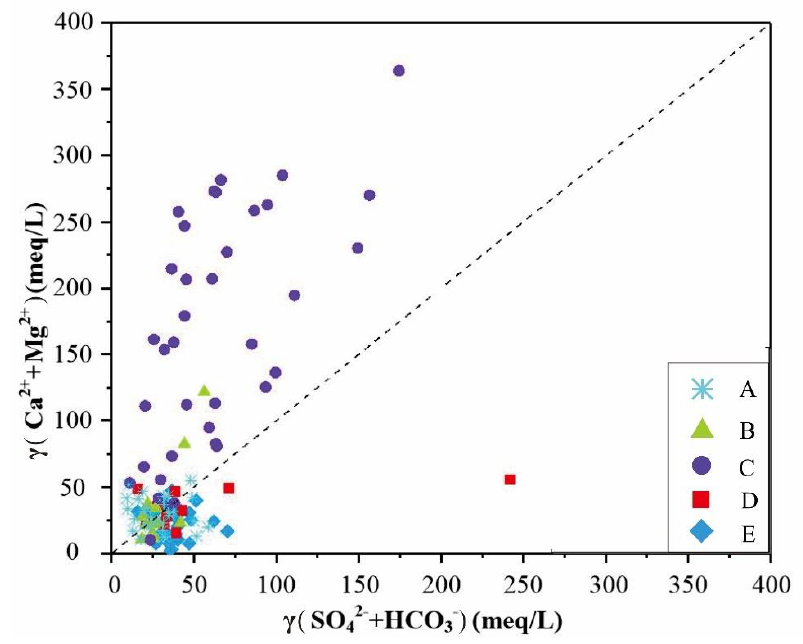
Figure 9. Relationship between γ (Ca 2+ + Mg 2+ ) and γ (SO 42 − + HCO 3 − ) in shallow groundwater of Hetao Plain. Hetao